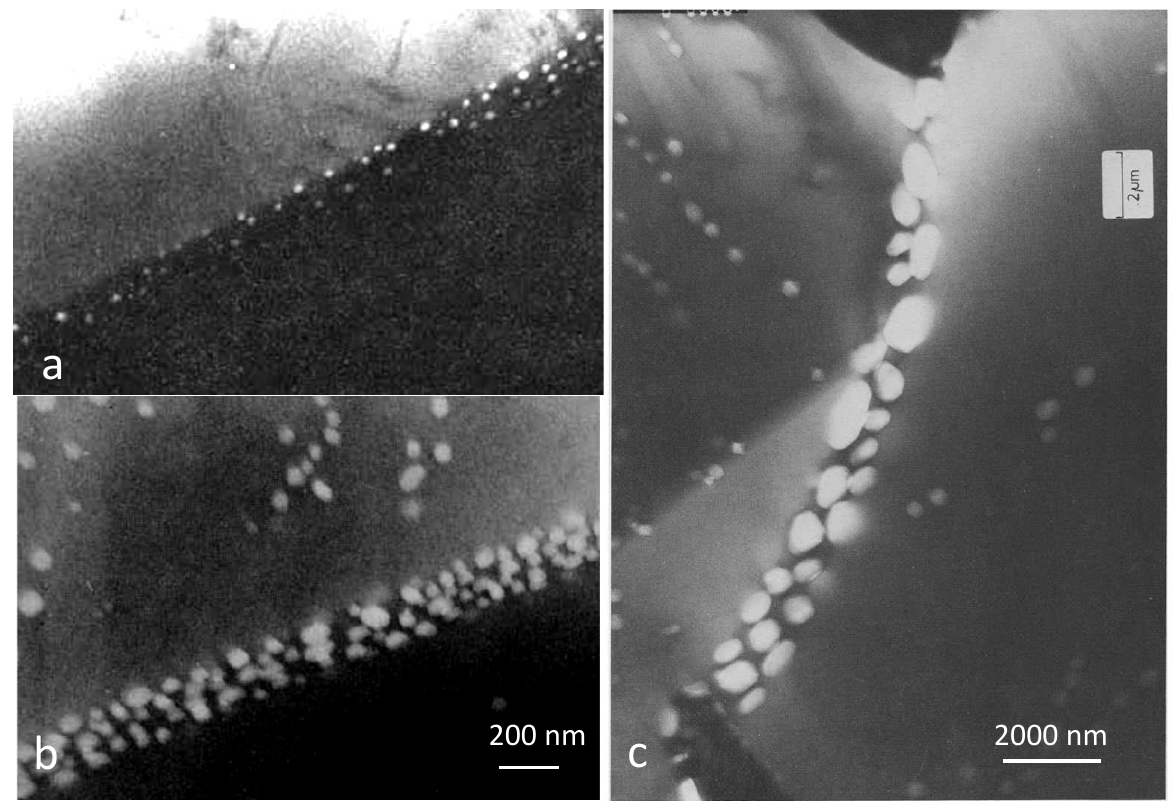
Figure 11. Comparison of bubble microstructures (TEM) for two samples of AISI 316 SS “in-beam” tested in tension to rupture at 1023 K at different stress levels. ( a ) σ = 77 MPa; t R = 5 h; [He] = 500 appm He; mean bubble diameter: 20 nm. ( b ) σ = 50 MPa: t R = 25 h; [He] = 2500 appm He: mean bubble diameter: 50 nm. ( c ) Same conditions as ( b ) showing preferential accumulation on a boundary perpendicular to a horizontal tensile stress. Modified from [43].